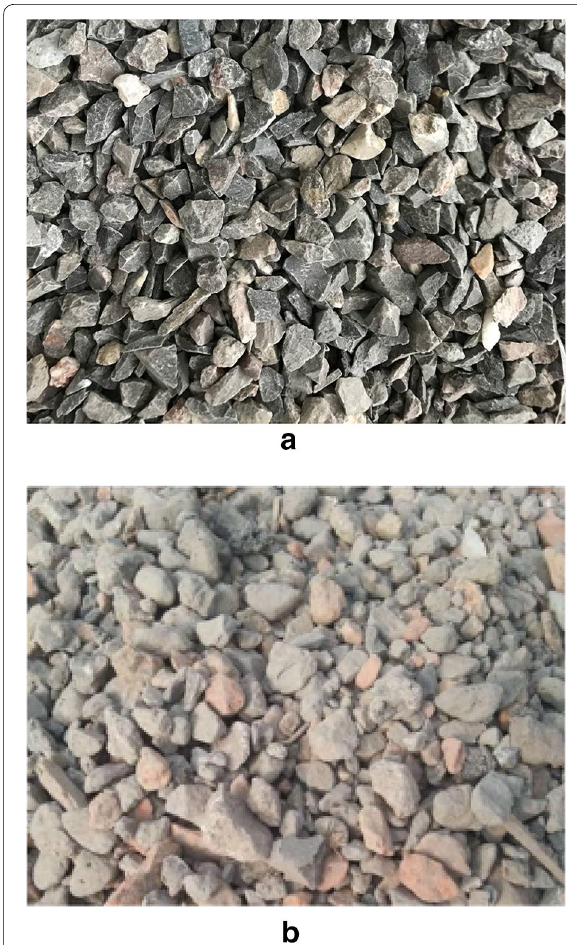
Fig. 1 Aggregates: a natural aggregates and b recycled aggregates.